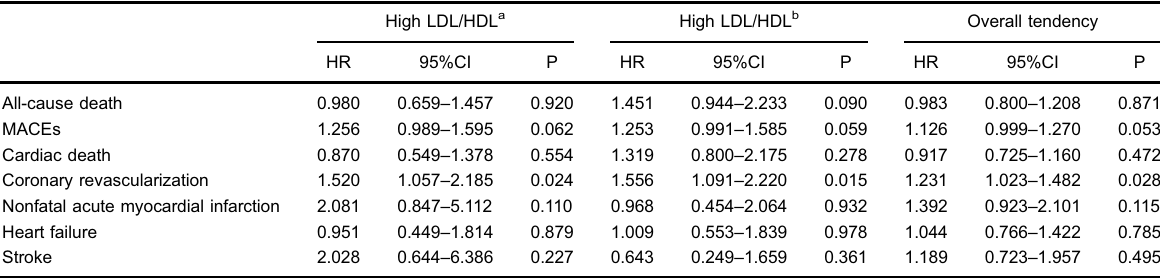
Table 3. Multivariate Cox regression analysis of the LDL/HDL ratio and clinical endpoints in STEMI